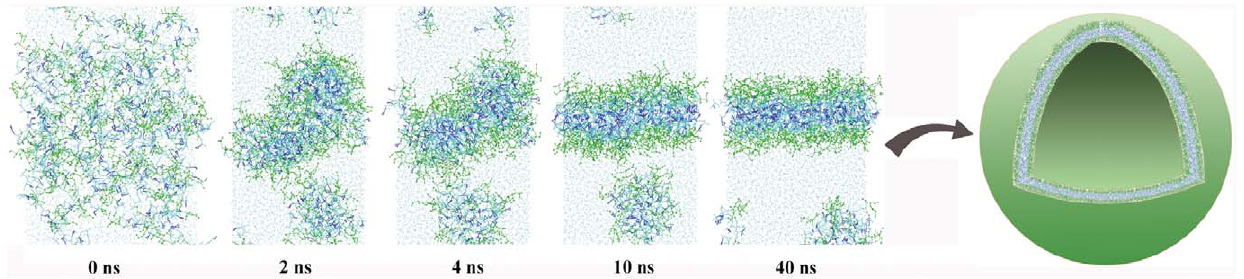
Figure 2. A coarse-grained simulation of bis(h 5 )-K-K 4 bilayer self-assembly. All lysine residues are plotted in green ball-and-stick representations, the aromatic sidechains of phenylalanine residues in blue sticks, and all other residues in cyan. The snapshots were taken at 0 ns, 2 ns, 4 ns, 10 ns and 40 ns, respectively. A hypothetical peptide vesicle model is shown to the right.